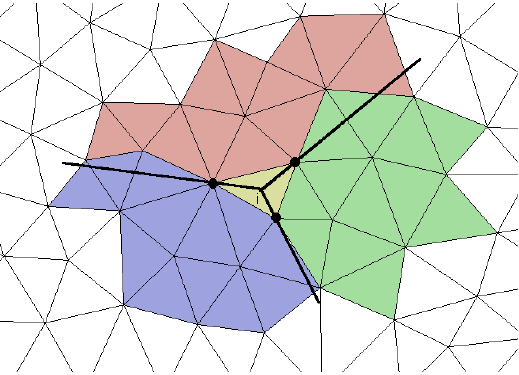
Figure 2. Definition of the three sectoral stencils for a triangular cell: in yellow, considered cell–two-dimensional